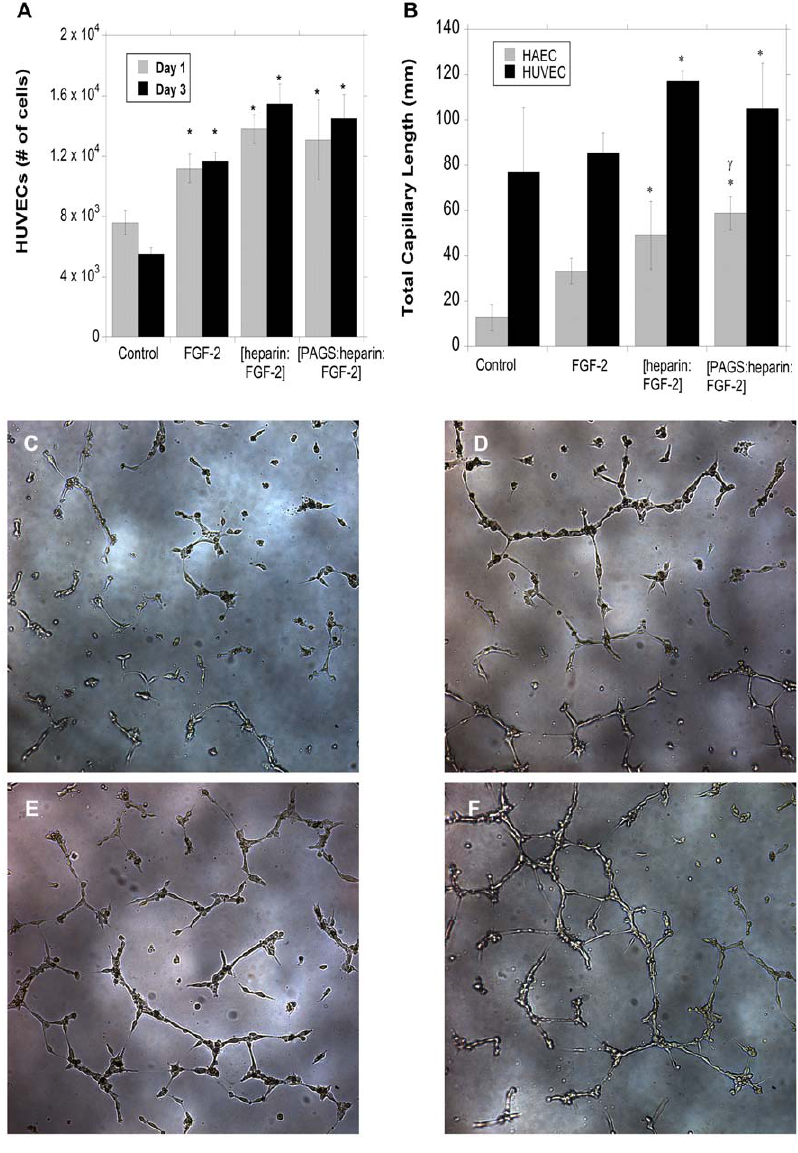
Figure 5. The bioactivity of the FGF-2 released from the [PAGS:heparin] delviery matrix is higher than bolus FGF-2 and matches that of heparin-protected FGF-2. Note that the growth factor in the release media were 1 and 3 days old, whereas the positive controls were fresh. [A] The mitogenic potency of the released FGF-2 from days 1 and 3 examined using HUVECs indicated that the bioactivity of FGF-2 is well maintained and matched that of the fresh heparin-protected FGF-2. [B] The released FGF-2 demonstrated ability to stimulate endothelial tube formation as well as fresh heparin-protected FGF-2 and is the only group that was statistically significantly better than blous FGF-2 in HAECs. Representative phase contrast micrographs of HUVECs incubated in: [C] no FGF-2, [D] fresh bolus FGF-2, [E] fresh [heparin:FGF-2], and [F] [PAGS:heparin:FGF-2] release media. Statistical significance between the negative control and other experimental groups was noted as ‘‘*’’, p , 0.05. # denotes the statistical significance between an experimental group and the bolus FGF-2 group, p , 0.05.